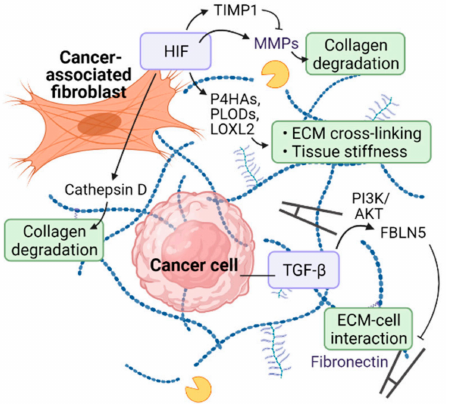
Figure 2. CAF-mediated ECM remodeling in hypoxia. Hypoxia regulates extracellular environ- ment via several mechanisms: post-translational modification of ECM proteins; ECM cross-linking; increasing ECM stiffness; collagen synthesis; collagen degradation; altering ECM-cell